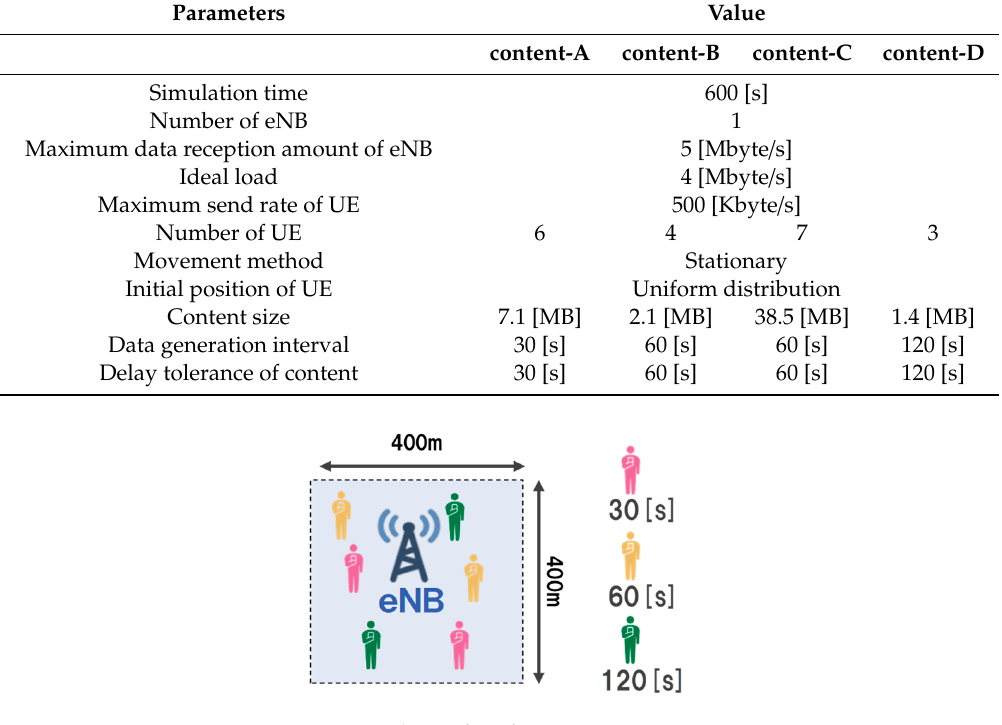
Table 5. Scenario for comparing performance.